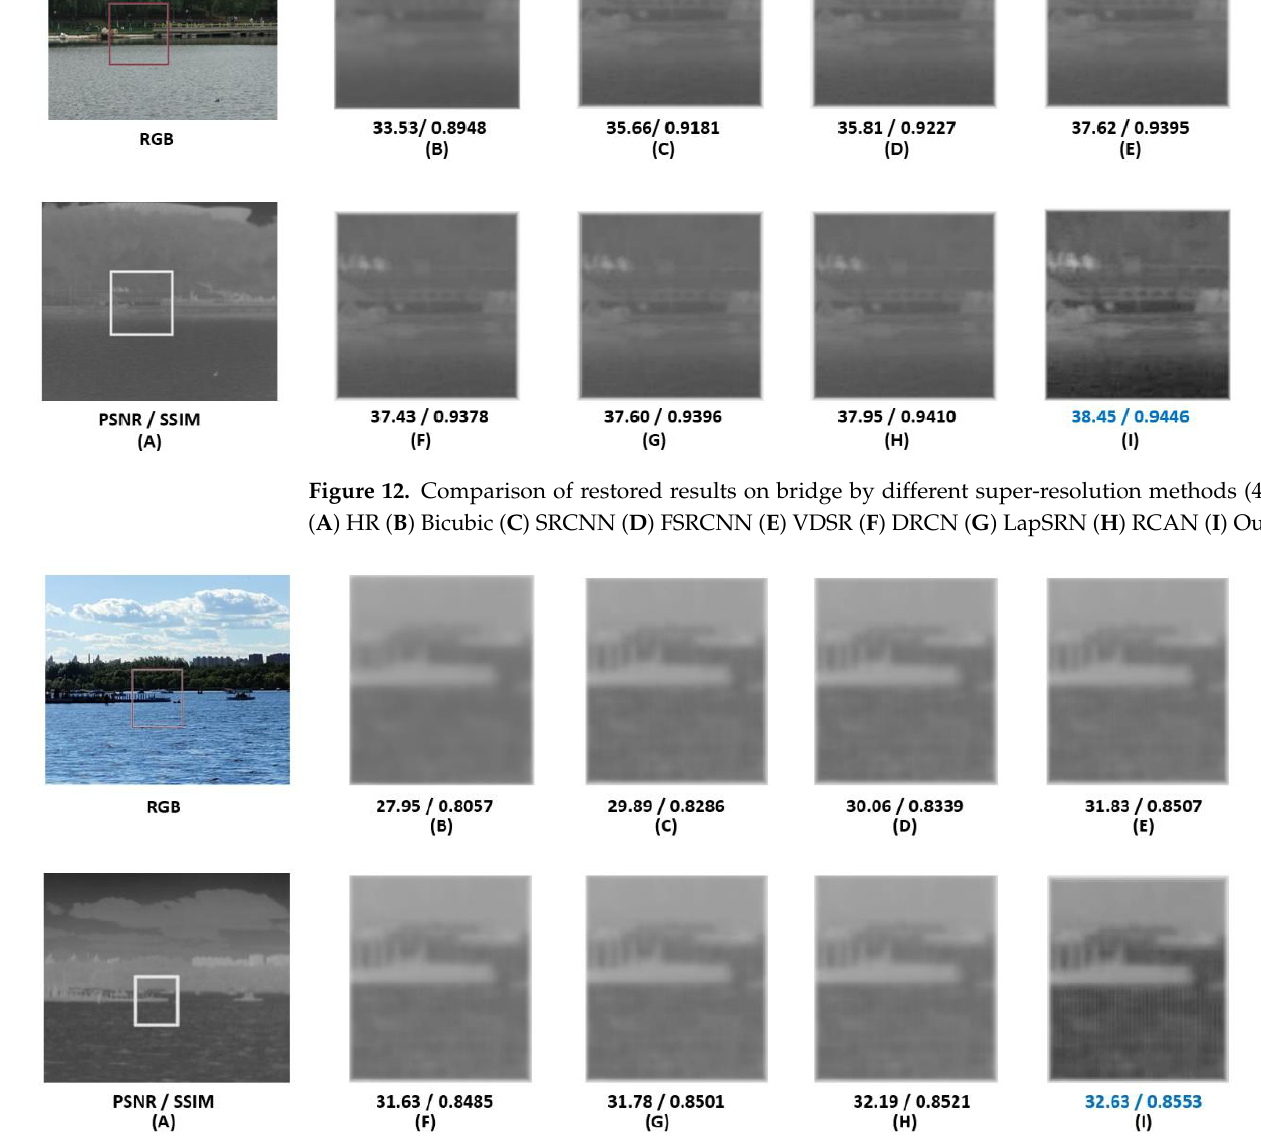
Figure 12. Comparison of restored results on bridge by different super-resolution methods (4×). ( A )